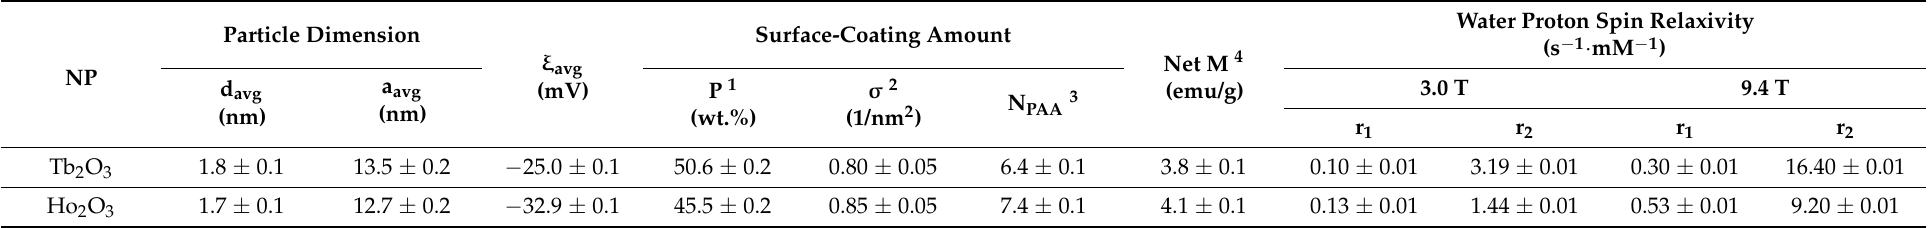
Table 1. Particle diameter (d), hydrodynamic diameter (a), zeta potential ( ξ ), surface-coating amount (P, σ , N PAA ), magnetic properties, and water proton spin relaxivities (r 1 , r 2 ) of the PAA-coated Ln 2 O 3 NPs (Ln = Tb and